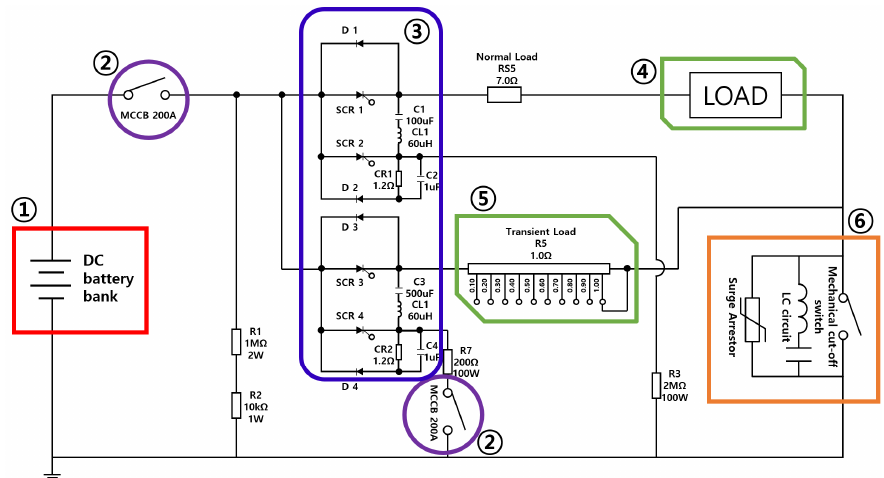
Figure 3. Circuit diagram of simulated accident generator in DC system.